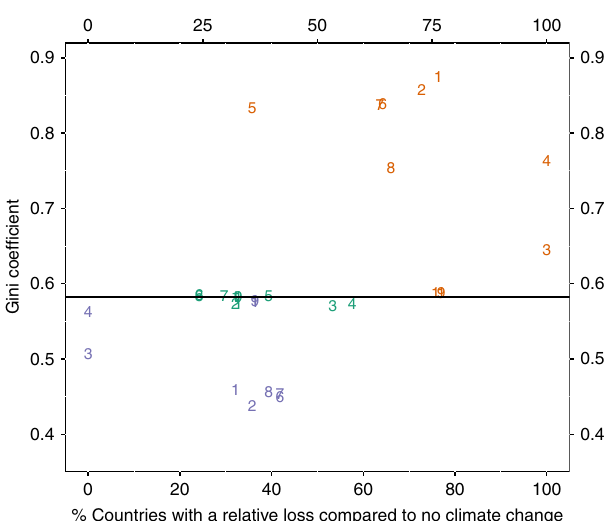
Fig. 4 Percentage of countries with a relative loss compared to no climate change versus country-level Gini Coef fi cients in 2099. Values represent median projections for Shared Socioeconomic Pathway 3 for RCP8.5 (orange), geoengineering-stabilized RCP8.5 (green) and geoengineering- mirrored RCP8.5 (purple) simulations. Numbers represent models speci fi